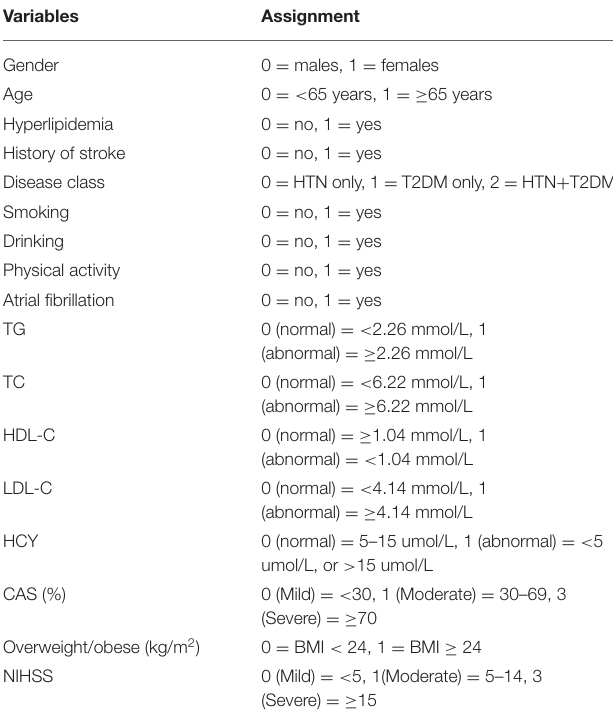
TABLE 4 | The assignment of main influencing factors of stroke incidence.